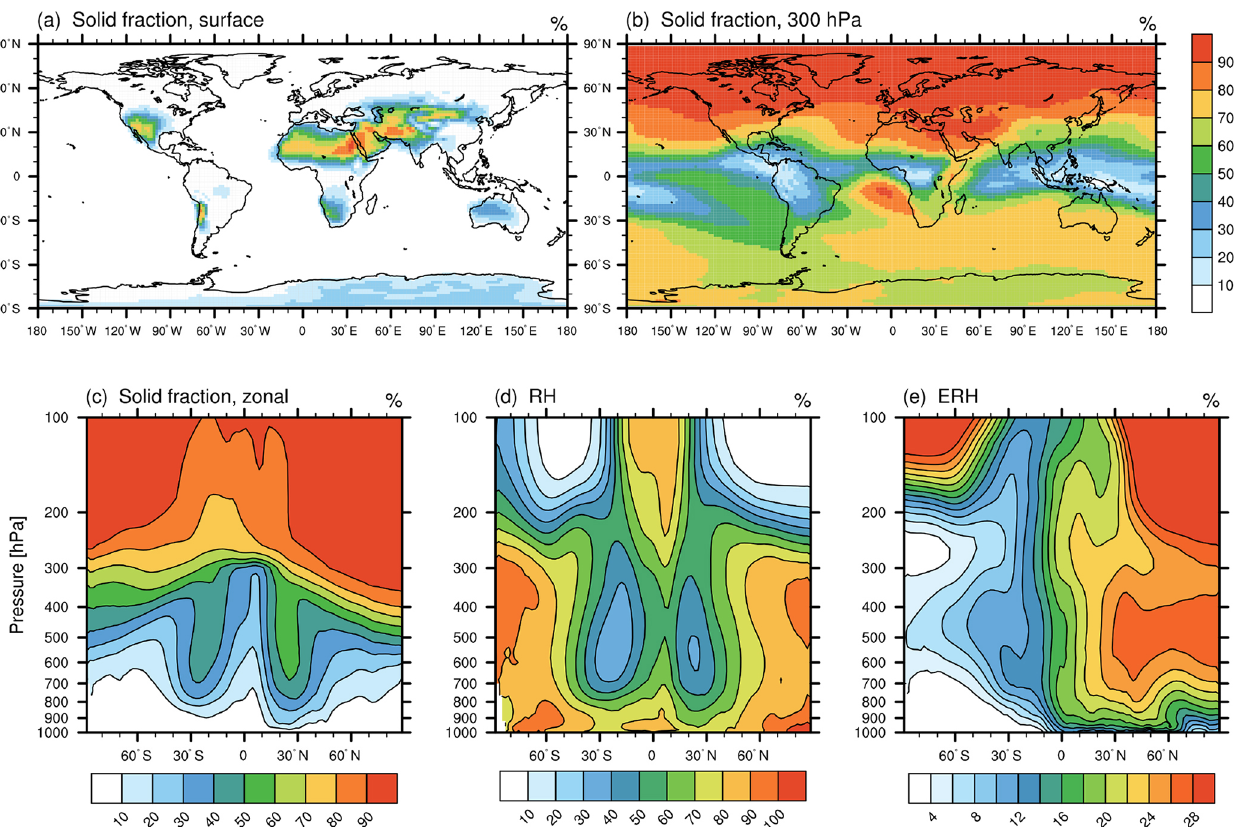
Figure 4. Simulated ammonium sulfate solid fractions in EMAC-MADE3, considering the multi-year average over the simulation period (2010–2019): the fraction of solid ammonium sulfate particles near the surface (a) , at 300hPa (b) , and as zonal-mean vertical distribution (c) ; (d) the zonal-mean relative humidity; and (e) the zonal-mean efflorescence relative humidity. All quantities are dimensionless and are shown as a percentage (%). Note the different scales in panels (d) and (e)